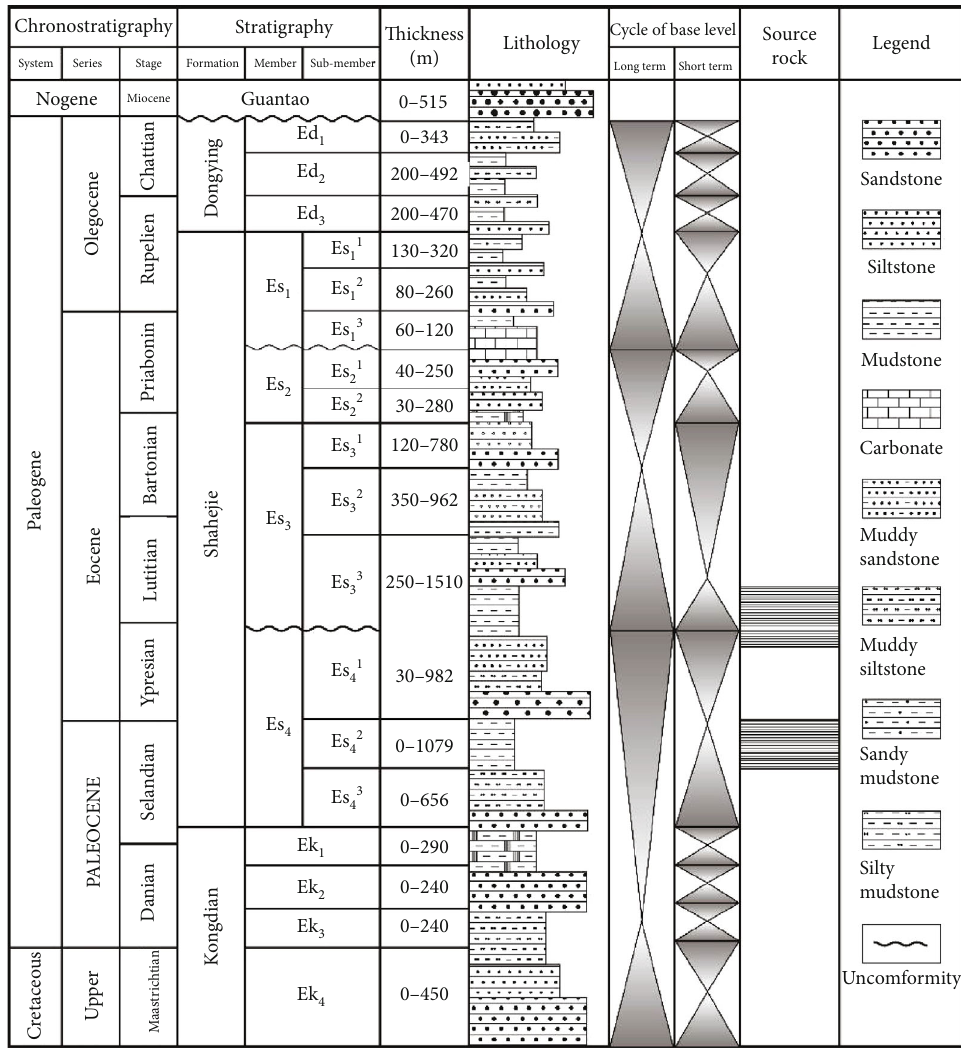
Figure 2: Regional composite lithostratigraphic column of the Raoyang Sag, with average thickness of the various stratigraphic units (modi fi ed from